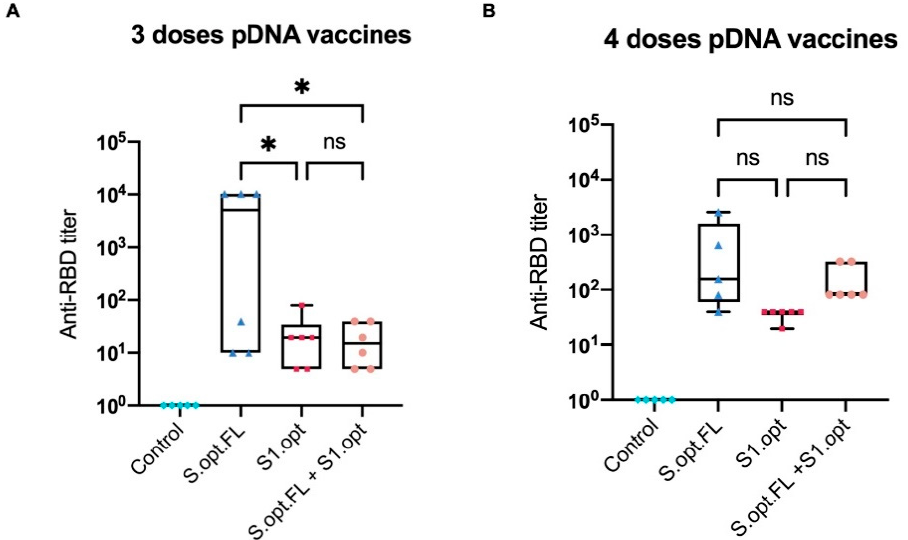
Figure 5. Box-and-whisker plot of surrogate virus neutralization test (sVNT). ( A ) Titer of anti- receptor-binding domain (RBD) IgG antibodies from serially diluted mice vaccinated sera taken 2 weeks after the third immunization. ( B ) Titer of anti-RBD IgG antibodies from serially diluted mice vaccinated sera taken 2 weeks after the fourth immunization. Cutoff titer was calculated as the serum highest dilution showing a cutoff value >20%. Data were analyzed with one-way ANOVA with Tukey’s multiple comparison test. The asterisks refer to the level of significance: * p < 0.033; ns: no significant difference.